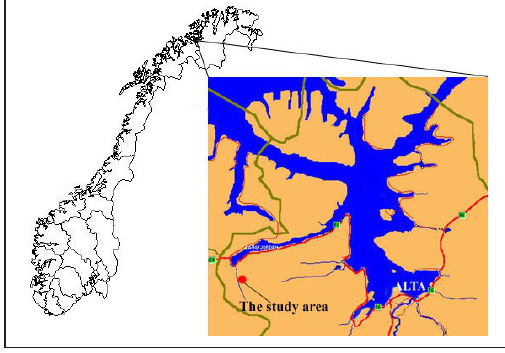
Fig. 1. Location of the study area in Bognelvdalen, West- Finnmark,